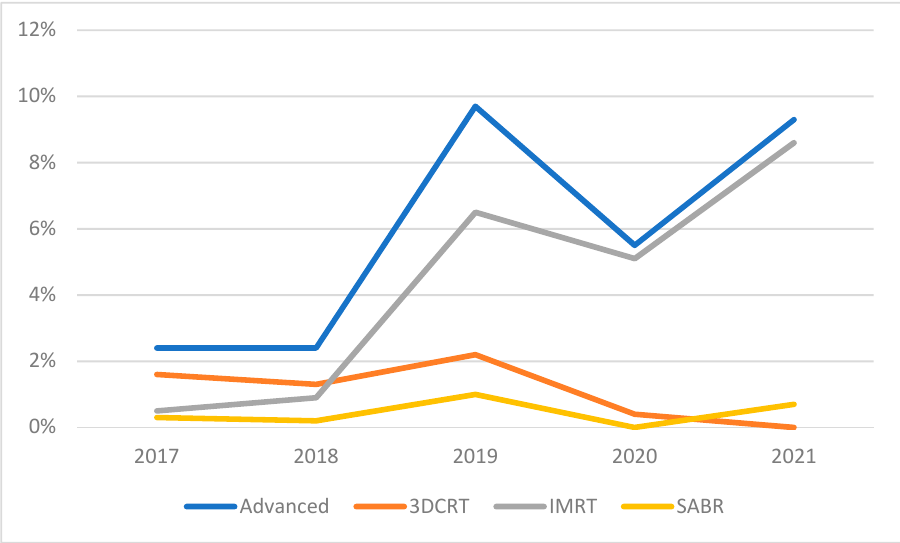
Figure 1. Use of advanced RT techniques over study duration. Baseline pain by technique did not differ (2.5 vs. 2.6; simple vs. advanced; p = 0.58) at baseline. As shown in Table 2, there was no difference in partial or complete pain response, while primary histology was associated with a partial pain response (Table 2). Table 2. Partial response and complete pain response by patient characteristics.